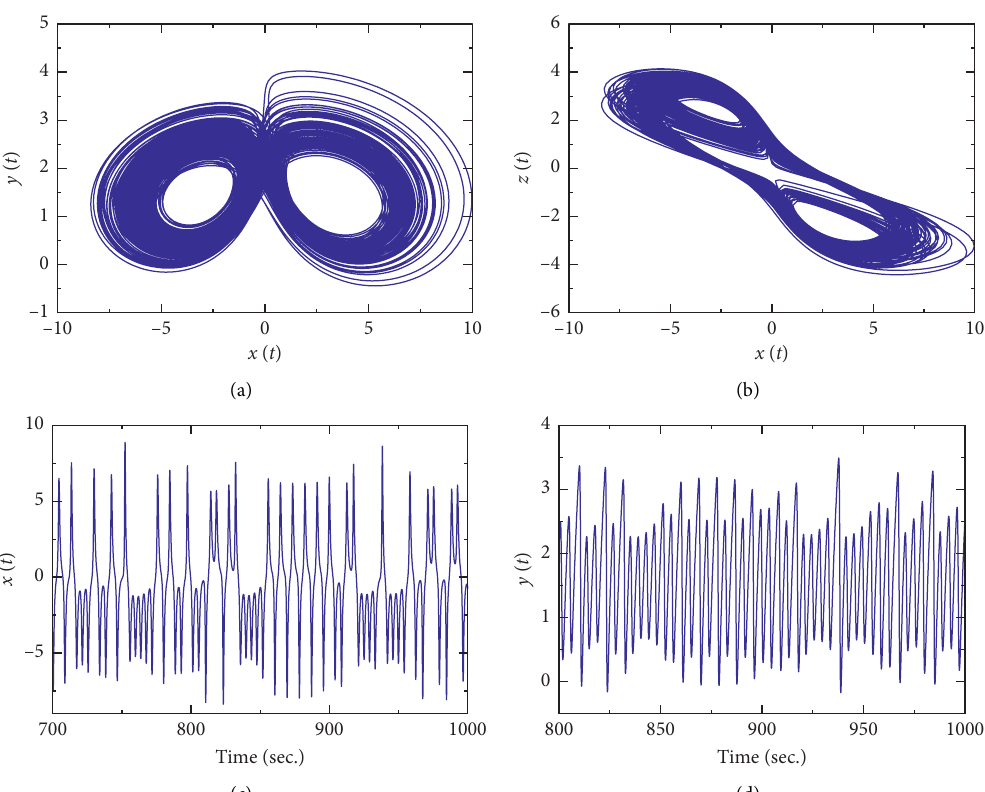
Figure 3: Phase diagrams and time series of system (6) with fractional order q � 0 . 83. (a) Projected onto the x − y phase plane. (b) Projected onto the x − z phase plane. (c) Time series of x . (d) Times series of y